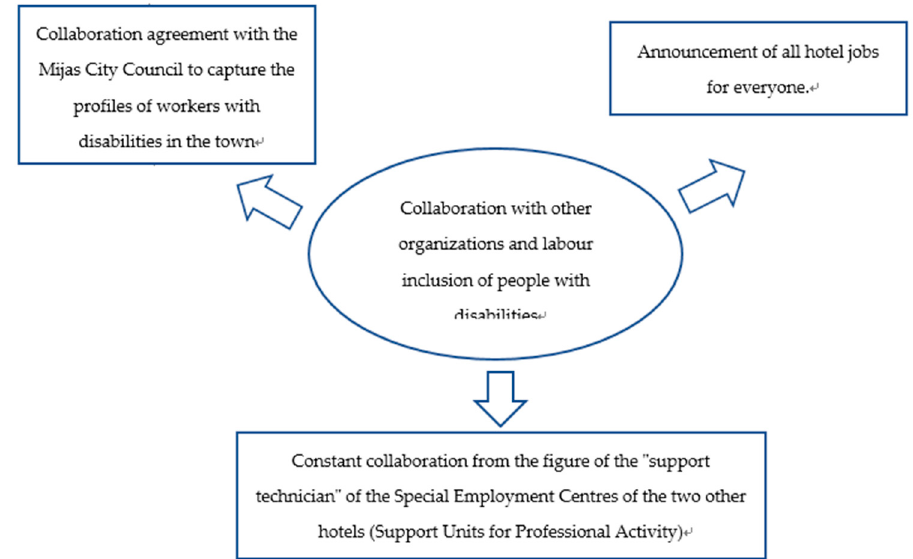
Figure 5. What collaboration actions are being carried out or are planned to be carried out with other organizations (public or private) regarding the labor inclusion of people with disabilities?